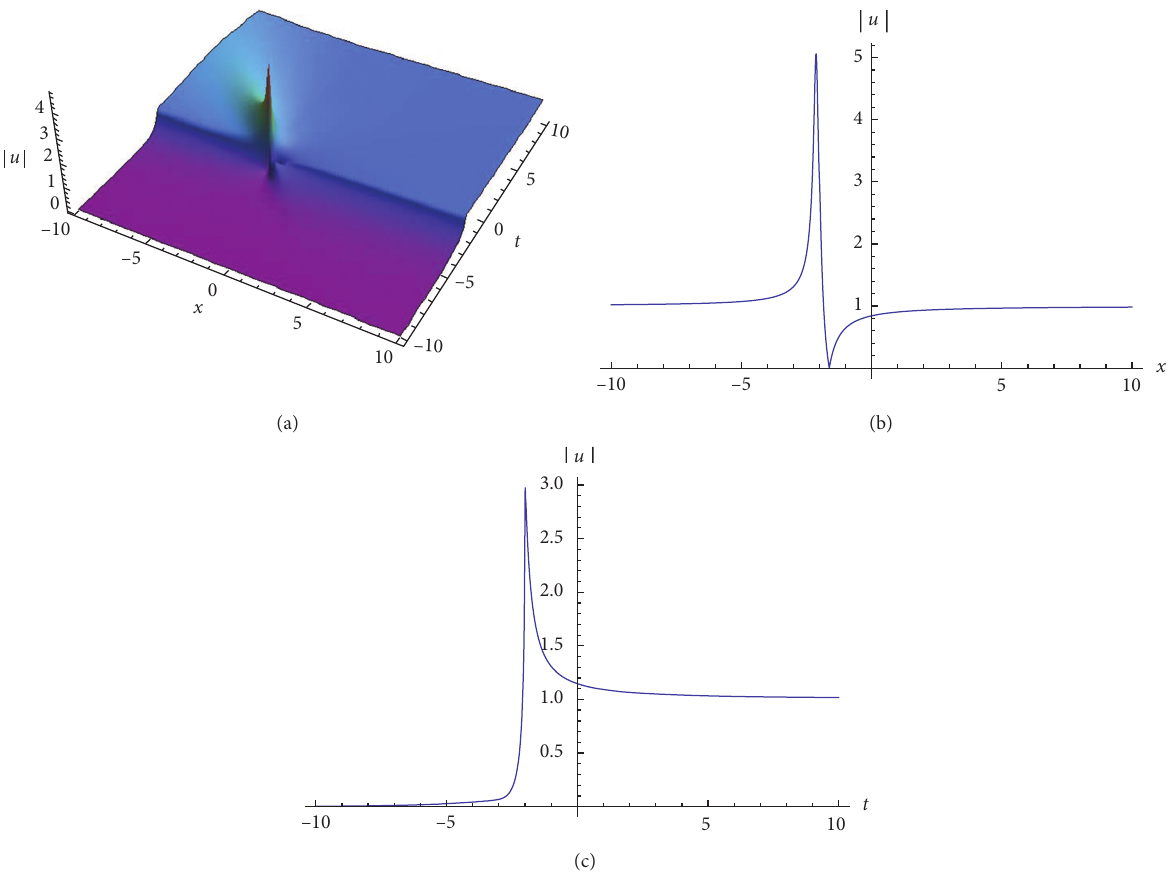
Figure 14: Asymmetric first-order fractional rogue wave (color online) and its amplitude and dynamic evolution with α � 5/8 and a � − 2 modified from solution (33).